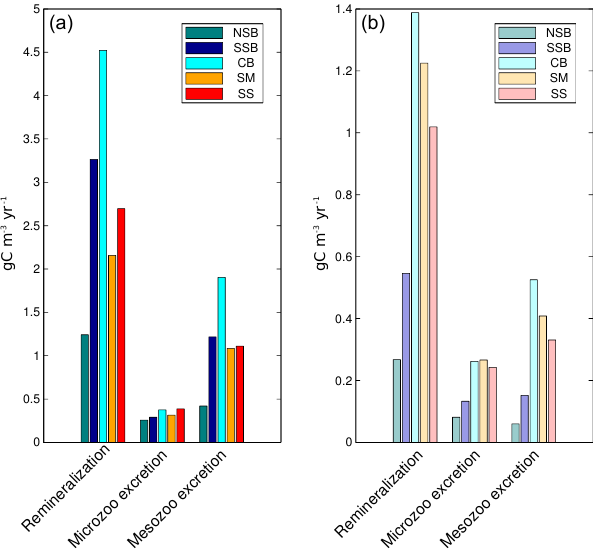
Figure 5. Remineralization rate of organic carbon (g Cm − 3 yr − 1 ) through microbial activity and zooplankton excretion (micro- and mesozooplankton) (a) averaged annually in the coastal boxes and (b) over the spring period (March–May) in the offshore boxes. Each colour corresponds to a box (see legend): northern Saharan Bank (NSB), southern Saharan Bank (SSB), Cape Blanc area (CB), Senegalo-Mauritanian region (SM) and southern Senegal region